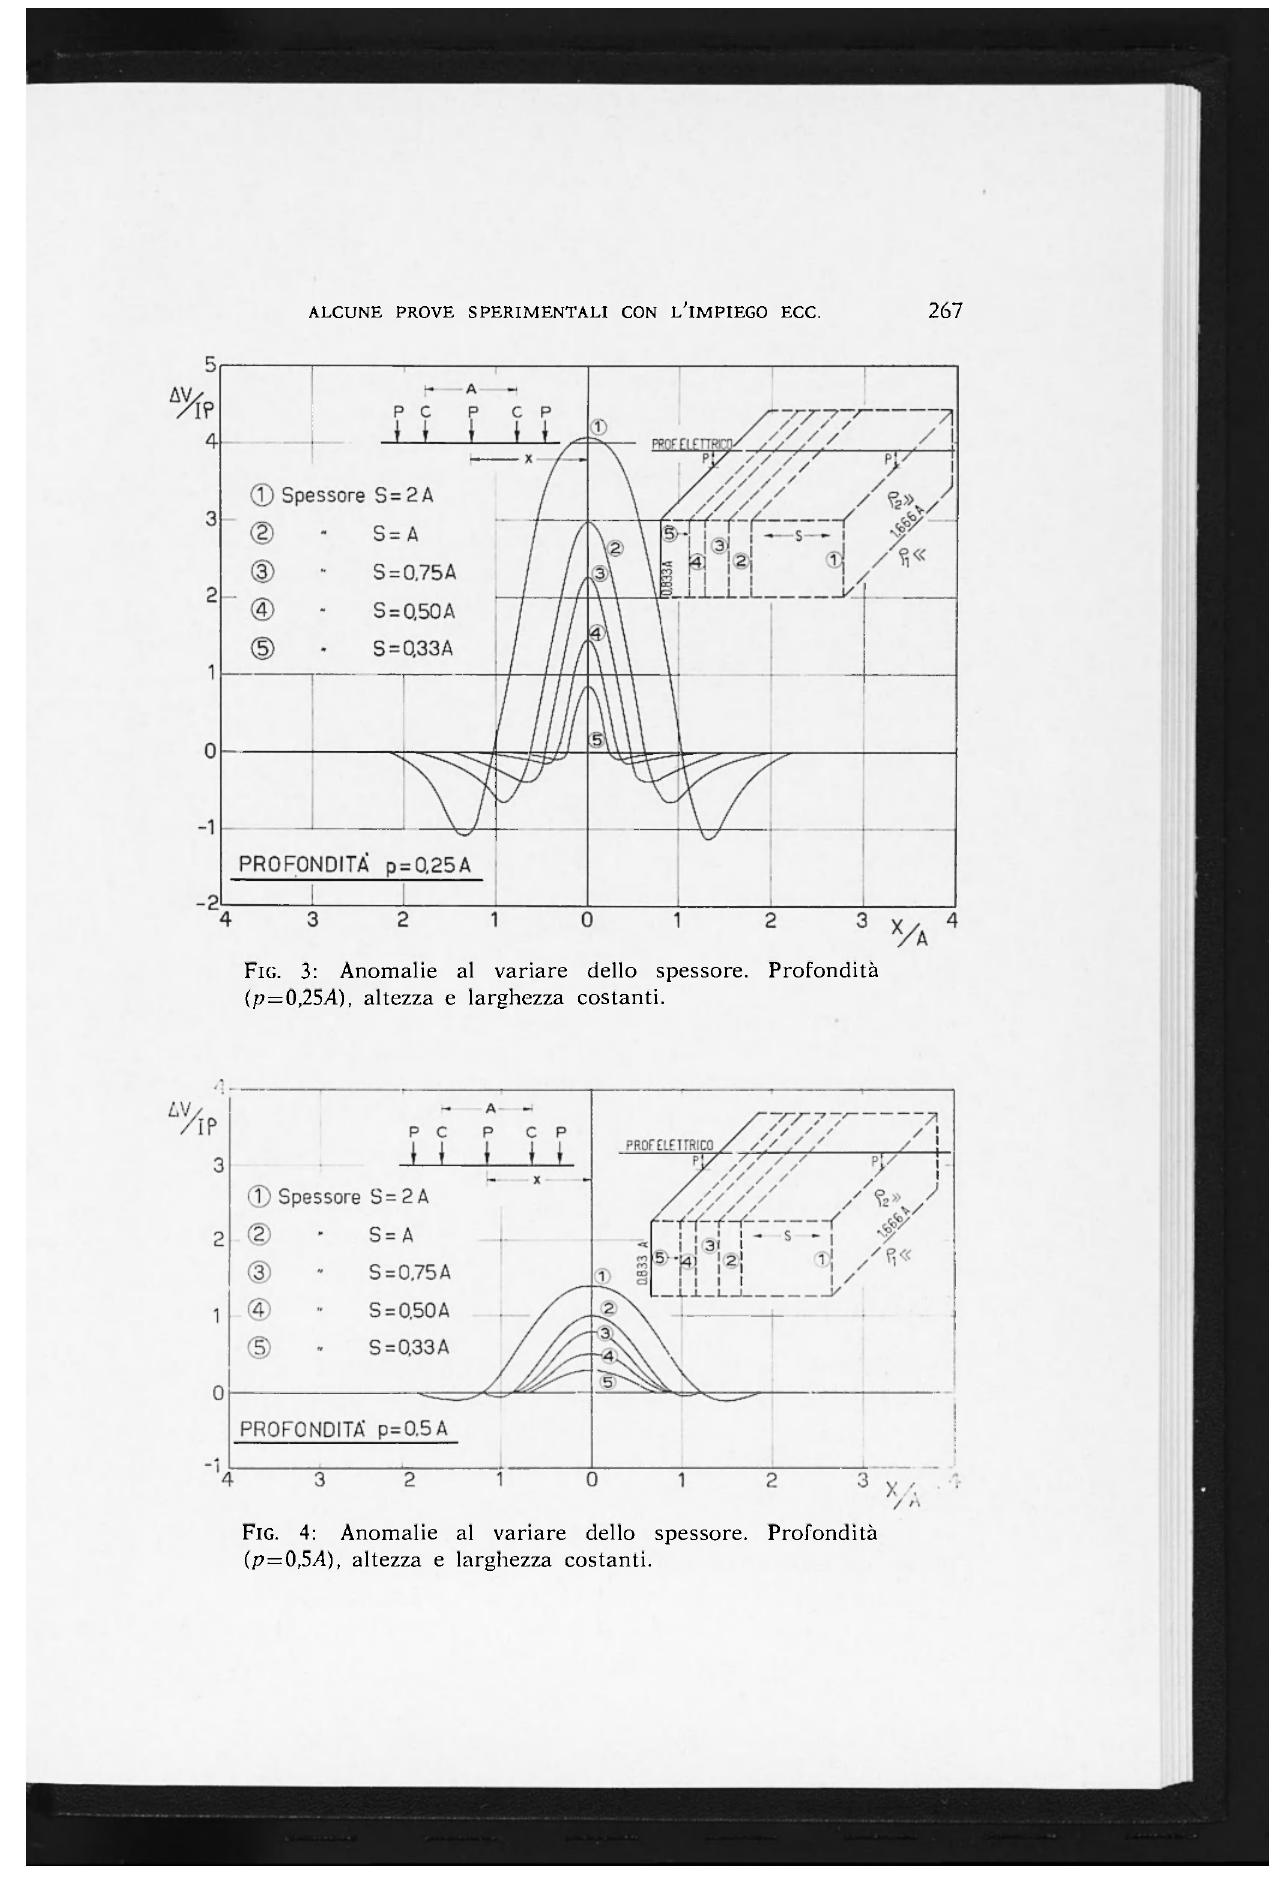
FIG. 4: Anomalie al variare dello spessore. Profondità (p=0,5/l), altezza e larghezza